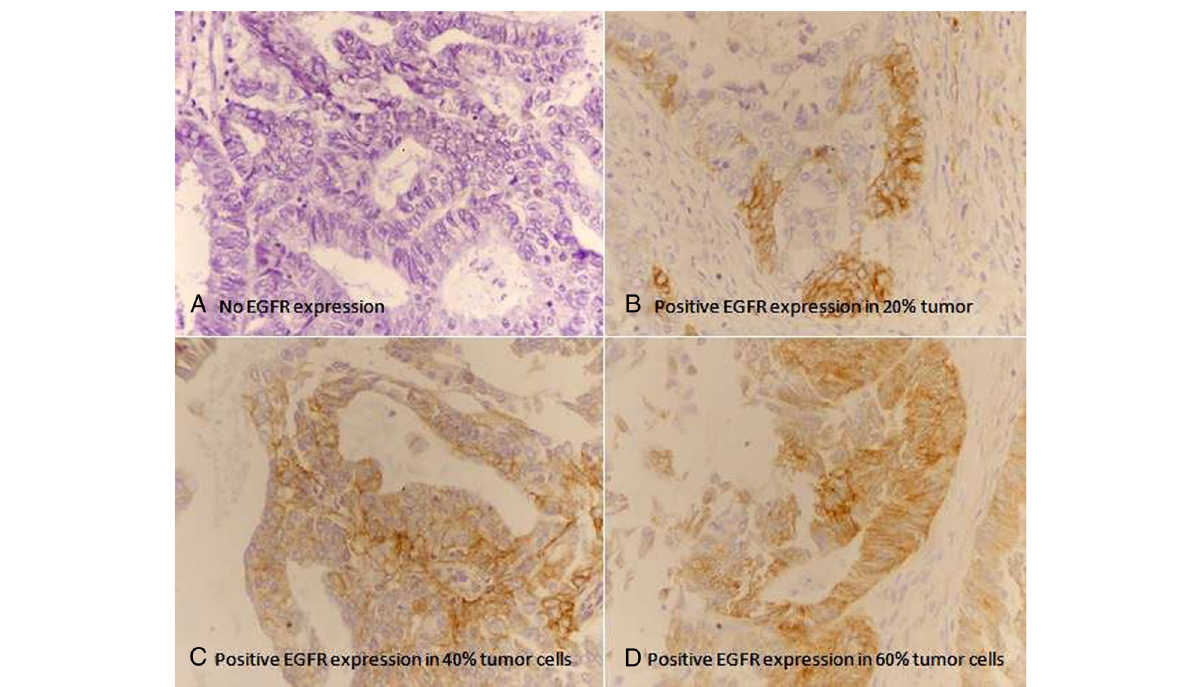
Fig. 1 Epidermal growth factor receptor (EGFR) expression in Endometrial